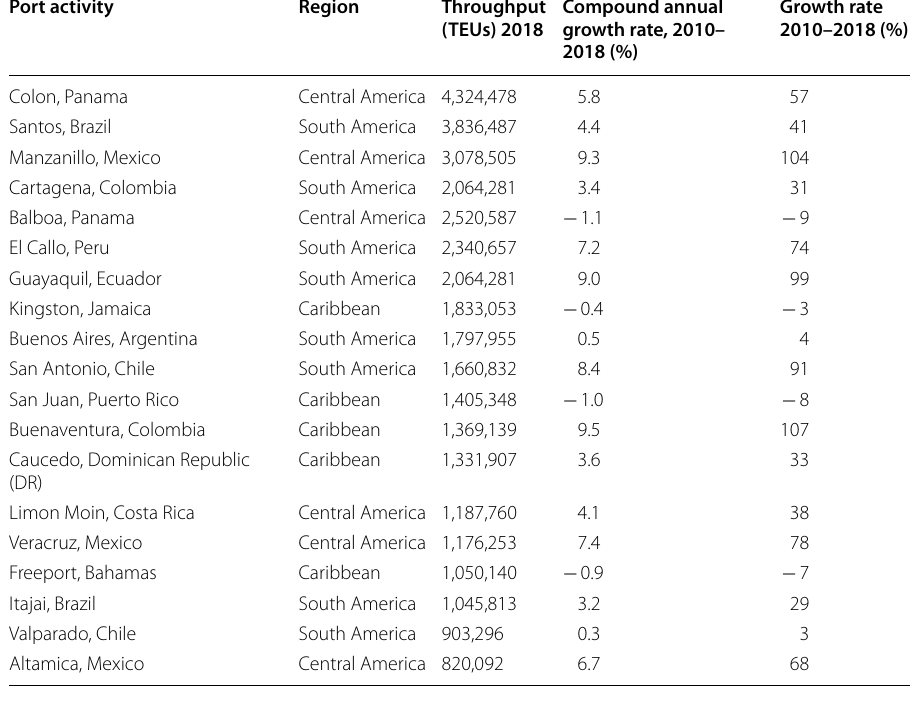
Table 4 LA America and the Caribbean top 19 ports (TEU). Source : Own elaboration Port activity Region Throughput